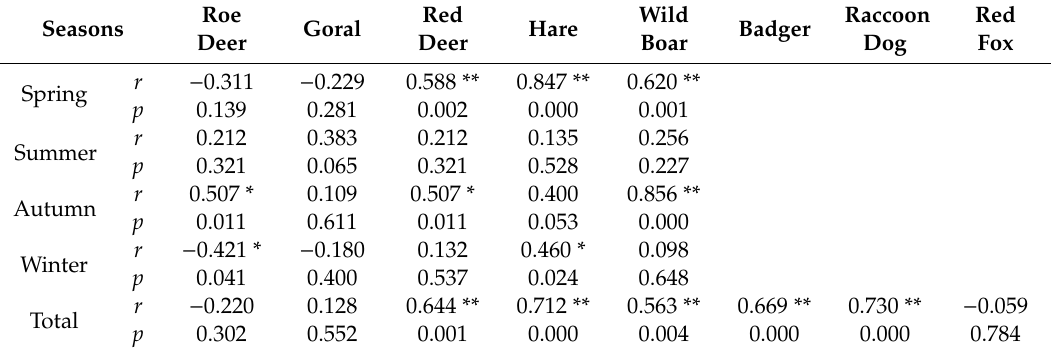
Table 2. Pearson correlation test between the lynx and its sympatric